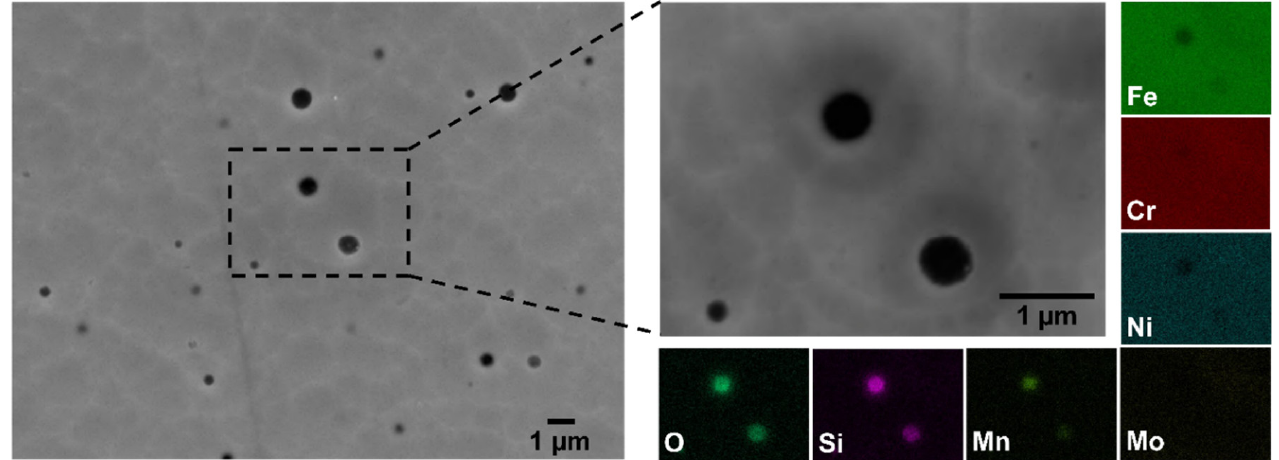
Figure 7. Secondary electron micrographs of regions in DED printed parts made up of several layers in which numerous manganese silicate inclusions can be observed (as measured with EDX analysis). The samples were fabricated with an overlapping of the clads of about 20%.